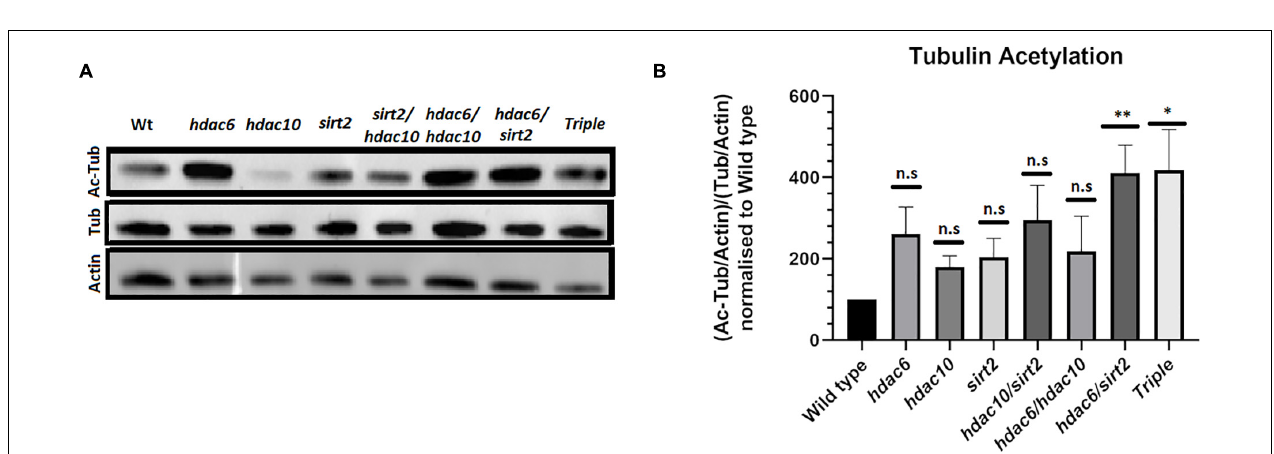
FIGURE 2 | Level of tubulin acetylation in adult fish eyes. (A) Western blot showing changes in tubulin acetylation in hdac mutants. (B) Quantification of Western blot signals normalized to actin loading controls (Mean with SEM n = 4. One-way ANOVA * p < 0.05, ** p < 0.01). ns, no significant.